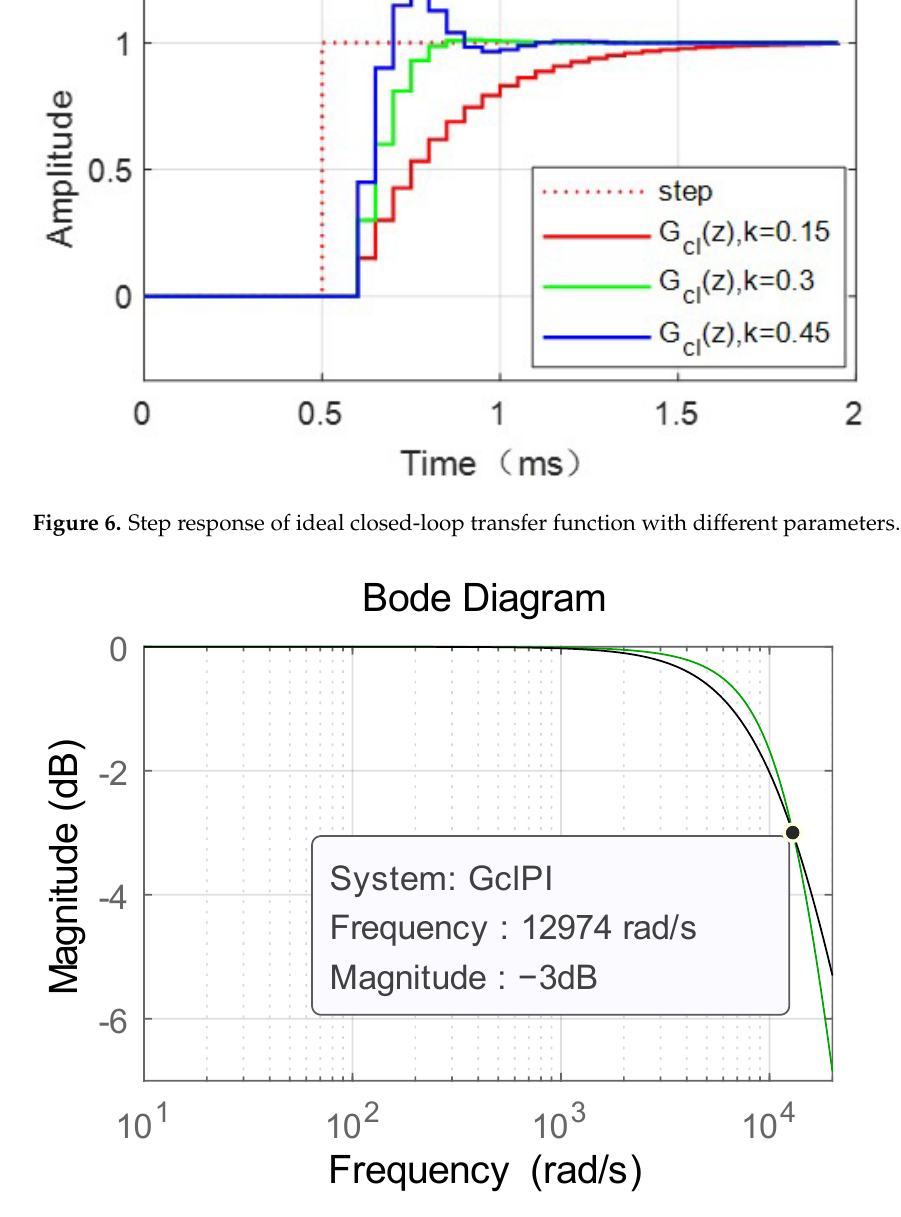
line, PI Black line, PI controller).